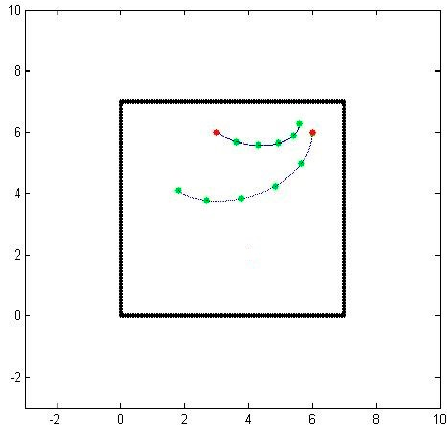
Figure 4. Consistent air-borne particle paths between two sensors.